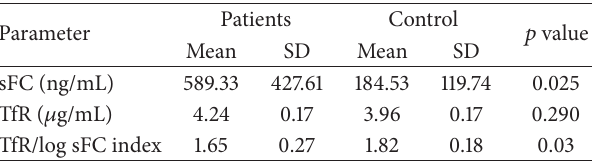
Table 3: Biochemical parameters in patients and controls.